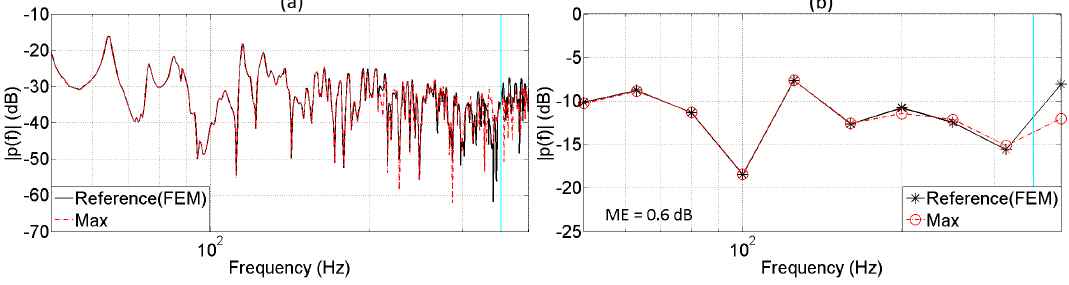
Figure 25. Comparison of full ( a ) and 1/3 octave band ( b ) frequency responses. Translated PWE ( W ) and reference ( W ) at translated Position 2.